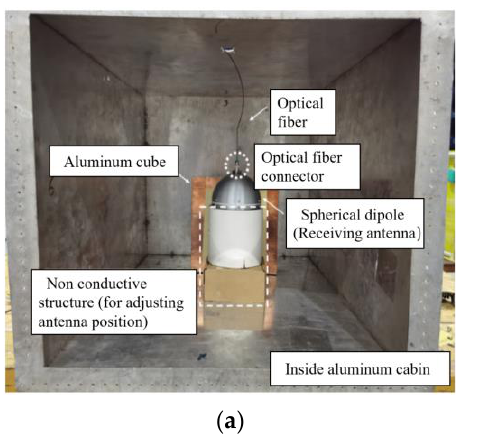
Figure 17. The internal and external layout of cavity shielding effectiveness (vertical antenna polar- ization). ( a ) Layout inside the cavity; ( b ) external arrangement of the cavity.